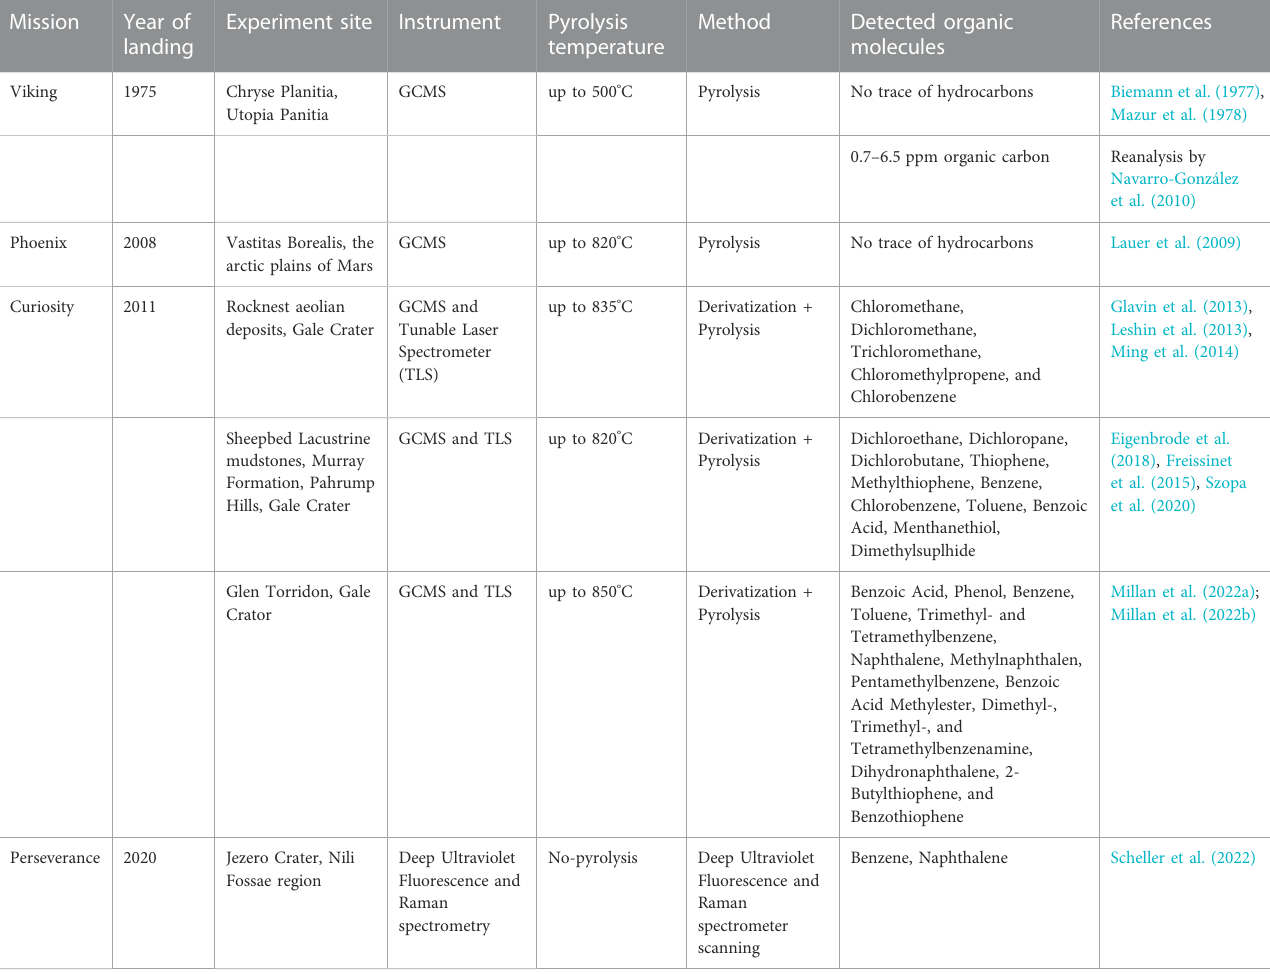
TABLE 1 Major Mars Lander missions and their organic analysis